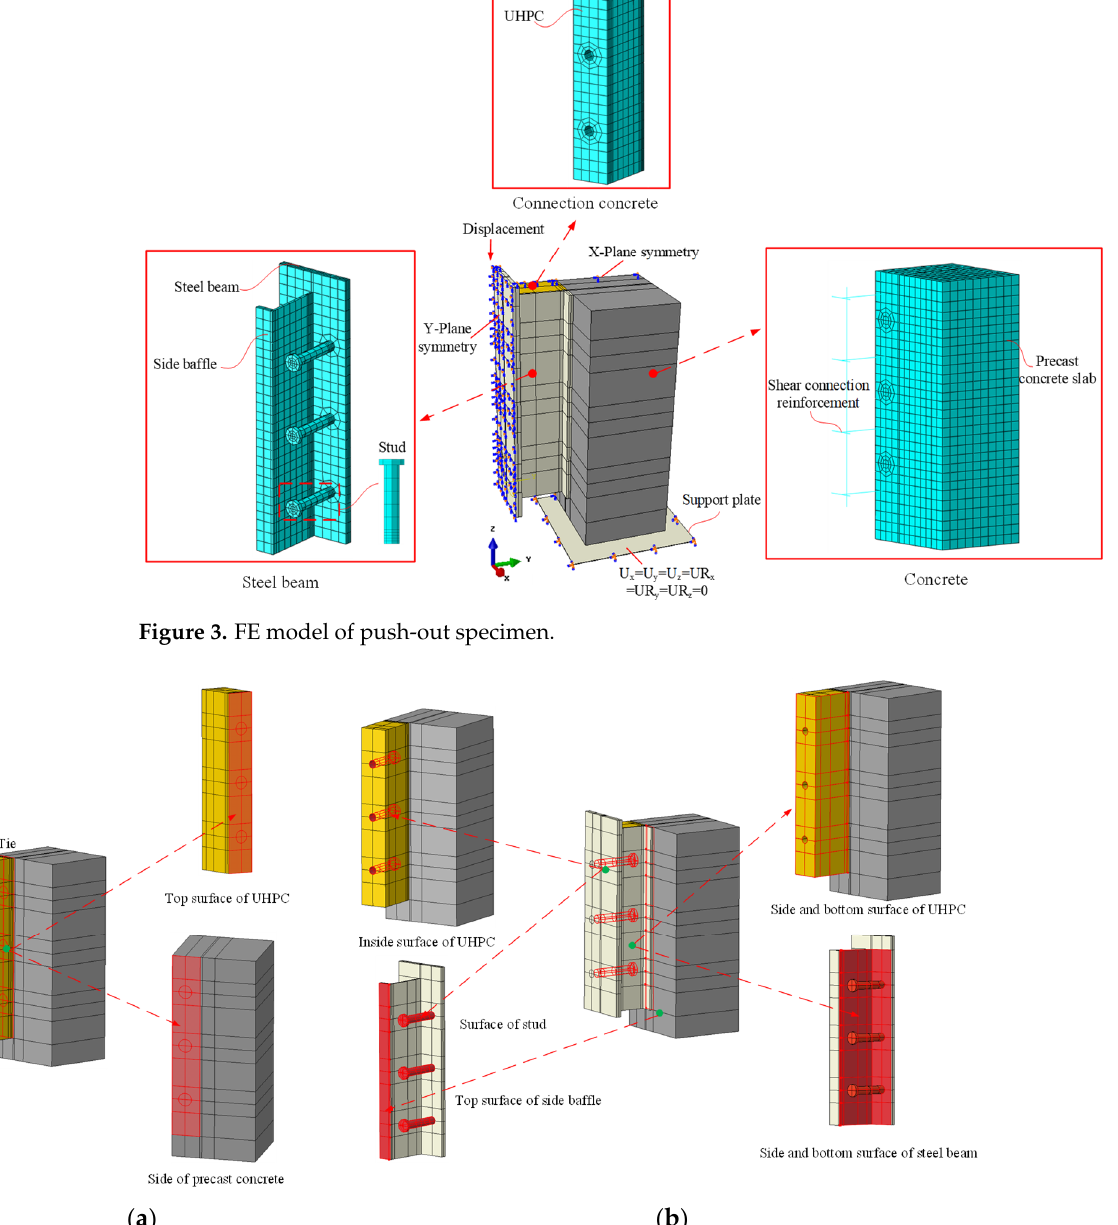
Figure 4. Interaction between steel and UHPC: ( a ) interaction at precast concrete-UHPC interface; ( b ) interaction at steel–UHPC interface. ( b ) interaction at steel–UHPC